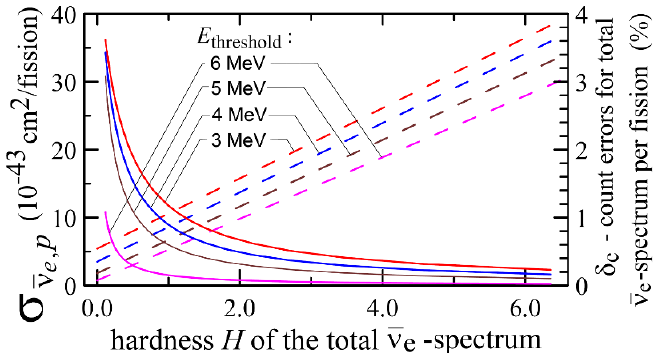
Figure 2 . Cross section of ((cid:22) (cid:23) e + p ! n + e + )-reaction (dash lines) and expected count errors (cid:14) C (solid lines) in the total (cid:22) (cid:23) e -spectrum as function of the hardness H . Values of cross sections at H = 0 correspond to (cid:22) (cid:23) e -spectrum from pure 235 U. The results are given for thresholds of registration: 3, 4, 5, 6